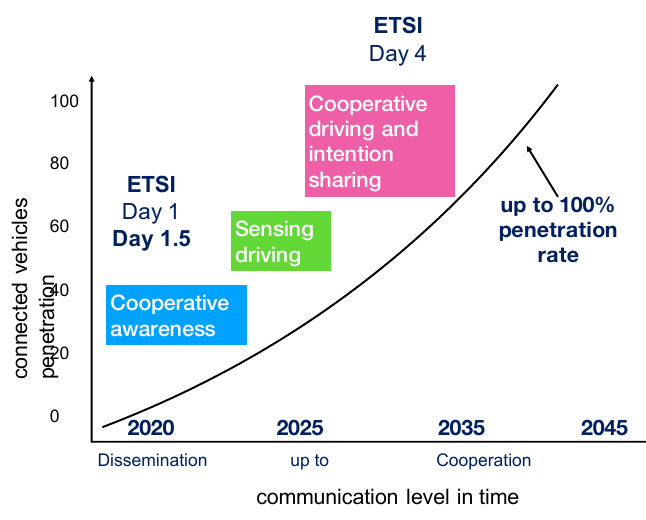
Figure 2. Applications roadmap of penetration of connected vehicles and ETSI priorities.